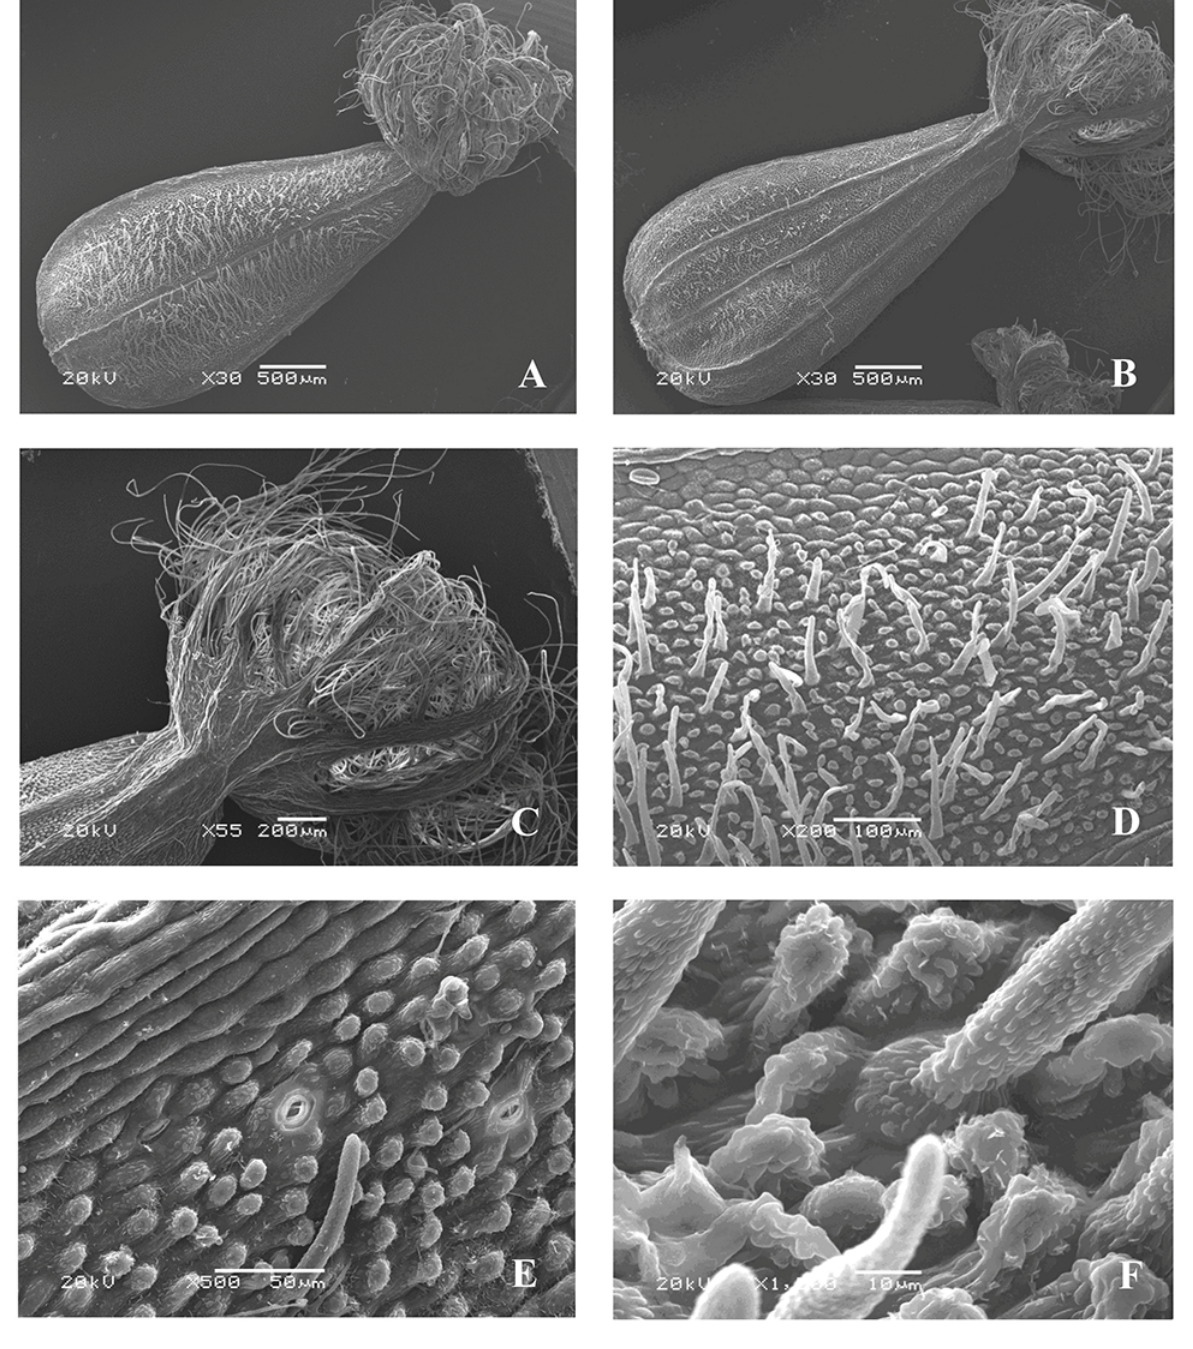
Figure 4 Fruit of Valeriana wolgensis (SEM): General view, adaxial side ( A ); general view, abaxial side ( B ); pappus-like calyx ( C ); fragments of the fruit surface ( D–F